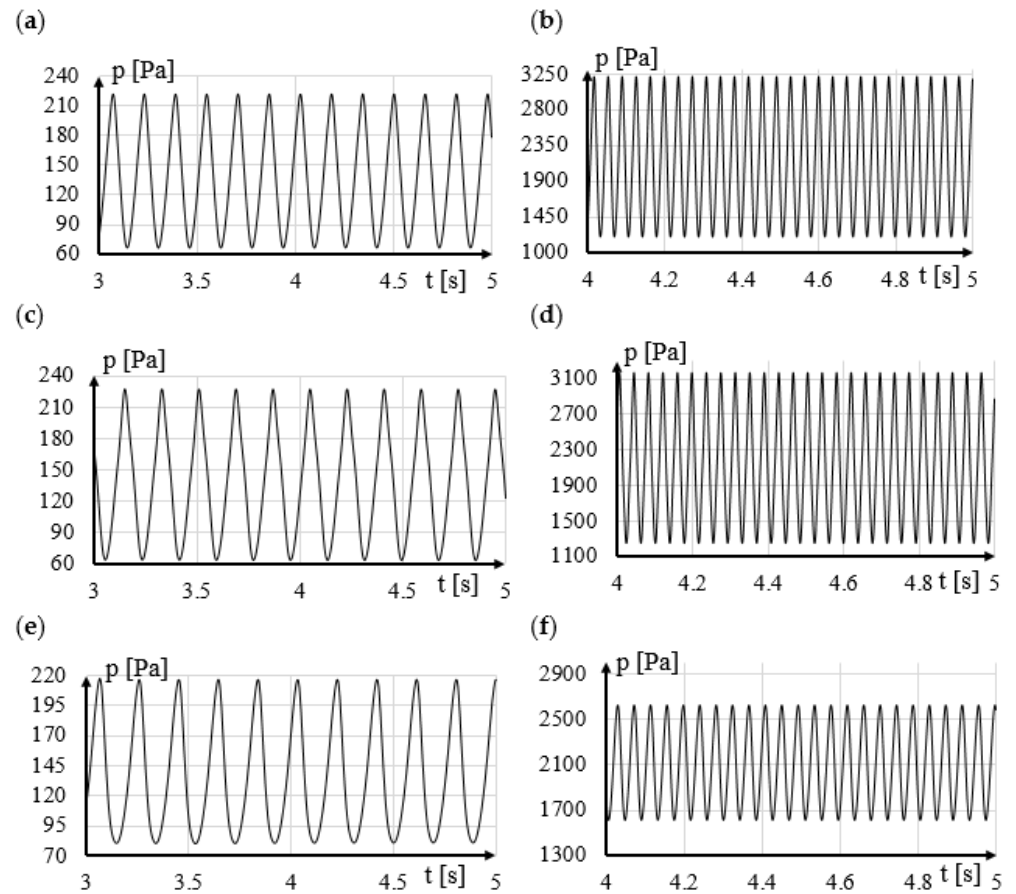
Figure 9. The influence of 5,6,7 and 8 surfaces modification on regularity of generated vortices for ( a ) T1 with v = 0.5 m/s, ( b ) T1 with v = 2 m/s, ( c ) T2 with v = 0.5 m/s, ( d ) T2 with v = 2 m/s, ( e ) T2 with v = 0.5 m/s, ( f ) T2 with v = 2 m/s.